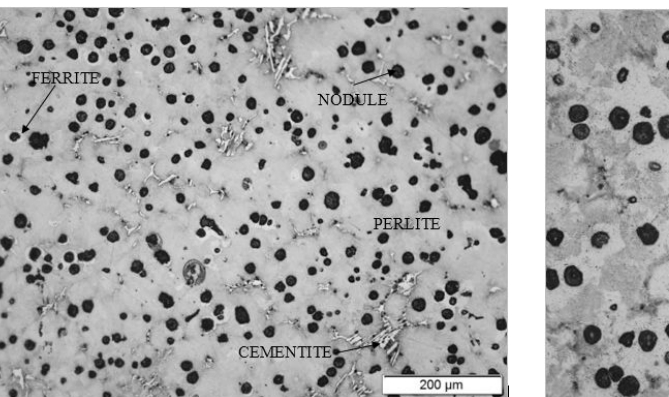
Figure 15. Matrix for Mo/Cu addition.